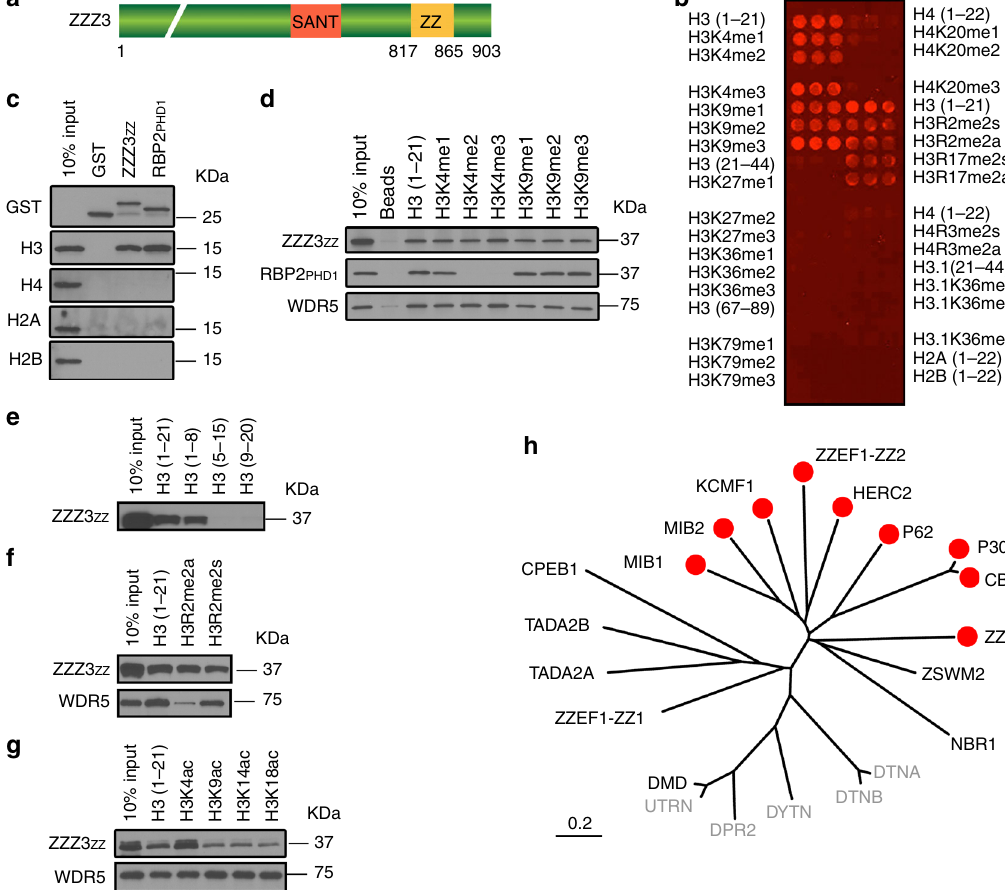
Fig. 1 The ZZ domain of ZZZ3 recognizes histone H3 tail. a Schematic representation of ZZZ3 protein structure. The amino acid numbers of ZZ domain and the full-length protein are shown. b Histone peptide microarray probed with GST-ZZZ3 ZZ domain. Each peptide has three replicates. c Western blot analysis of GST pulldowns of GST-ZZZ3 ZZ with calf thymus histones. Pulldown of GST-RBP2 PHD1 is shown as a control. d Western blot analysis of peptide pull-down experiments of GST-ZZZ3 ZZ domain with the indicated histone H3 peptides. Peptide pulldowns of RBP2 PHD1 and WDR5 are shown for comparison. e – g Western blot analysis of peptide pulldown experiments of GST-ZZZ3 ZZ domain with the indicated H3 peptides. Peptide pulldowns of WDR5 are shown for comparison. h Phylogenetic tree presentation of the H3-binding activity of human ZZ proteins. The red dot indicates binding with H3 (Supplementary Fig. 1c – e). The cytoplasmic ZZ proteins (gray) are not tested in this